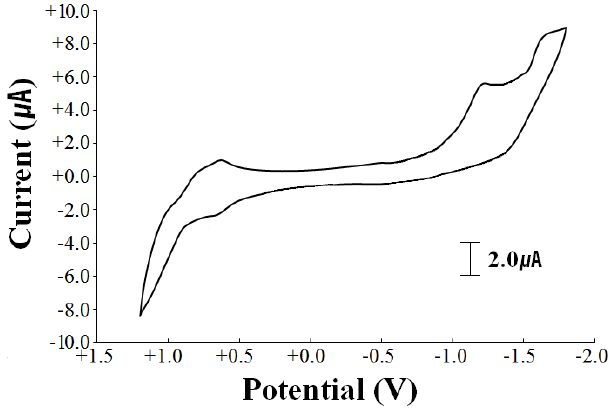
Figure 4. Cyclic voltammogram of [Ni(L)(H-cpdc  ) at 20.0 ± 0.1 °C. The scan rate is 100